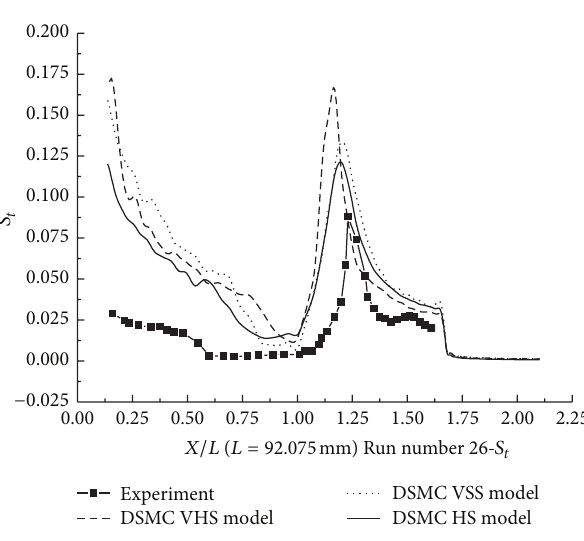
Figure 13: DSMC simulation of Run number 26 ( 𝑆 𝑡